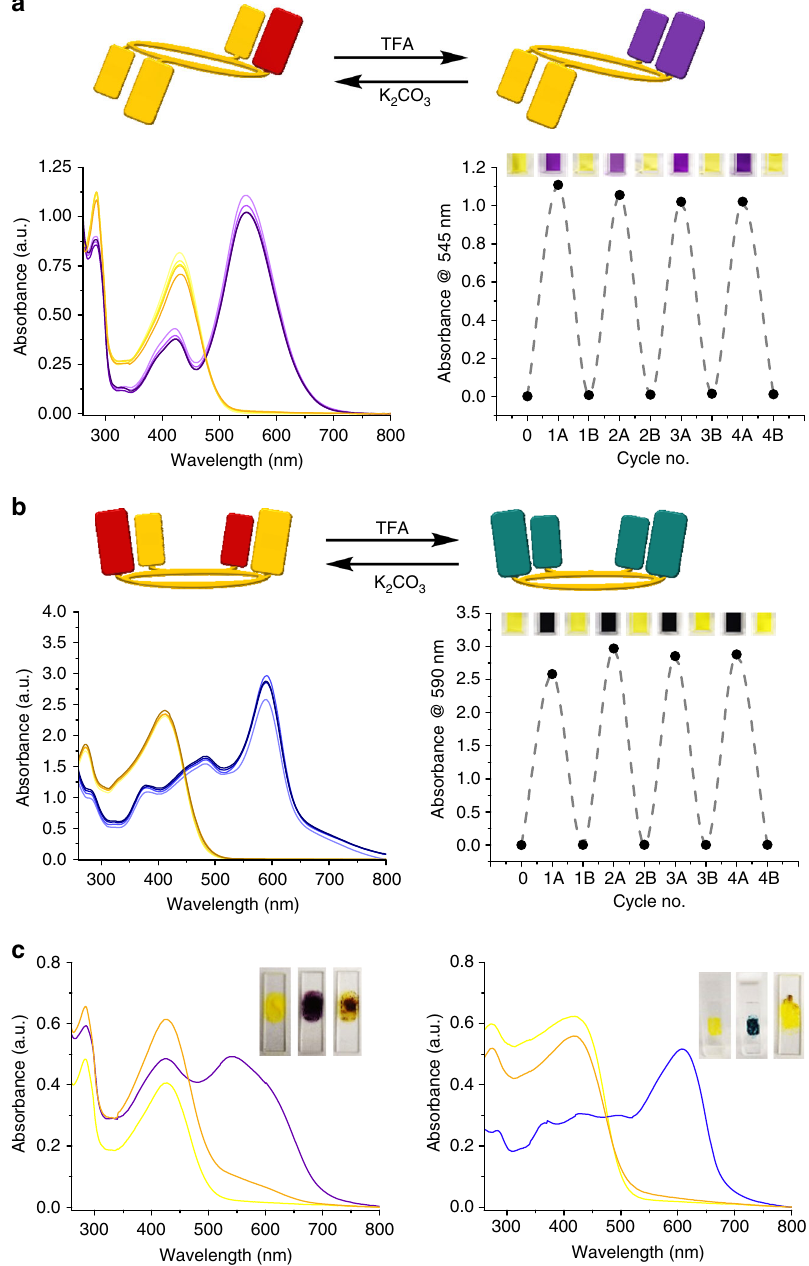
Fig. 4 Charge-transfer state switching of rctt- 2 -[Ox 1 ] and rccc- 2 -[Ox 2 ]. a Top: graphical representation of hemiquinhydrone formation in rctt- 2 -[Ox 1 ] with (at left) the corresponding electronic absorption spectra of rctt- 2 -[Ox 1 ] during sequential acidi fi cation (tri fl uoroacetic acid (TFA), 50 μ L) and neutralization (K 2 CO 3 ) at 9.02× 10 − 5 mol dm − 3 in CHCl 3 demonstrating reversibility of charge-transfer complex formation with the alternating absorbance intensity shown at right (colored squares are photographs of the corresponding solution in cuvette). b Top: graphical representation of hemiquinhydrone formation in rccc- 2 -[Ox 2 ] with (at left) the corresponding electronic absorption spectra of rccc- 2 -[Ox 2 ] during sequential acidi fi cation (TFA, 175 μ L) and neutralization (K 2 CO 3 ) at 9.02 × 10 − 5 mol dm − 3 in CHCl 3 and (at right) alternating absorbance intensity for the repeated process (colored squares are photographs of the corresponding solution in cuvette). c Solid-state electronic absorption spectra of rctt- 2 -[Ox 1 ] (left) and rccc- 2 -[Ox 2 ] (right) before (yellow spectra), during (purple/blue spectra) and after (orange spectra) exposure to TFA vapor. Inset photographs show the corresponding color changes in the solid-state samples deposited on quartz